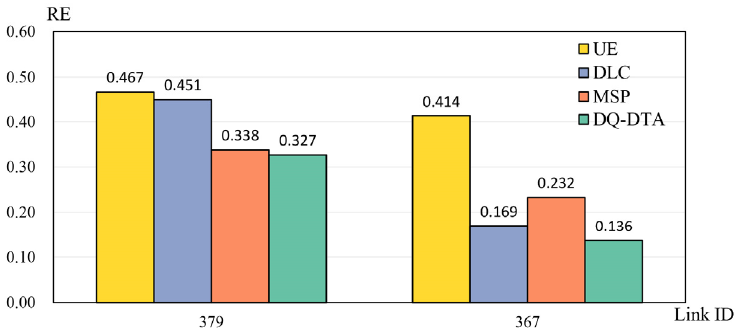
Figure 9. The relative error on the chosen two links of the UE, DLC, MSP, and DQ-DTA models.